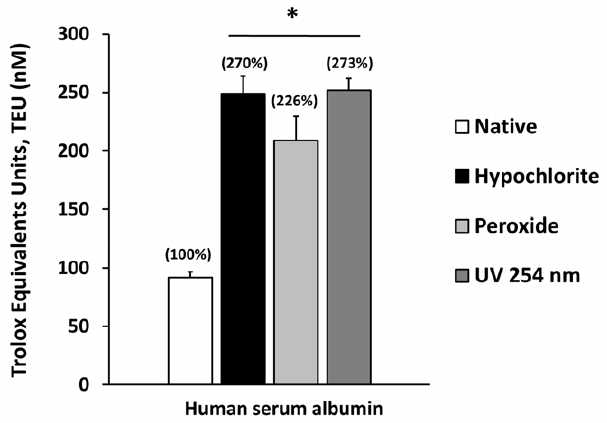
Figure 1. The Antioxidant Capacity (AC) of albumin and the Response Surplus (RS) as a novel component of the albumin antioxidant properties induced by structural stress. The antioxidant capacity was measured before and after albumin incubation with sodium hypochlorite (NaOCl) and hydrogen peroxide (H 2 O 2 ) for 10 minutes and exposure to UV light for 15 seconds. The Antioxidant Capacity Accumulated (ACA %) appears above the bars. RS values correspond to ACA%-100 as specified in the Material and Methods section. Results are expressed as mean 6 SD (n=6). *P , 0.001 vs. Native